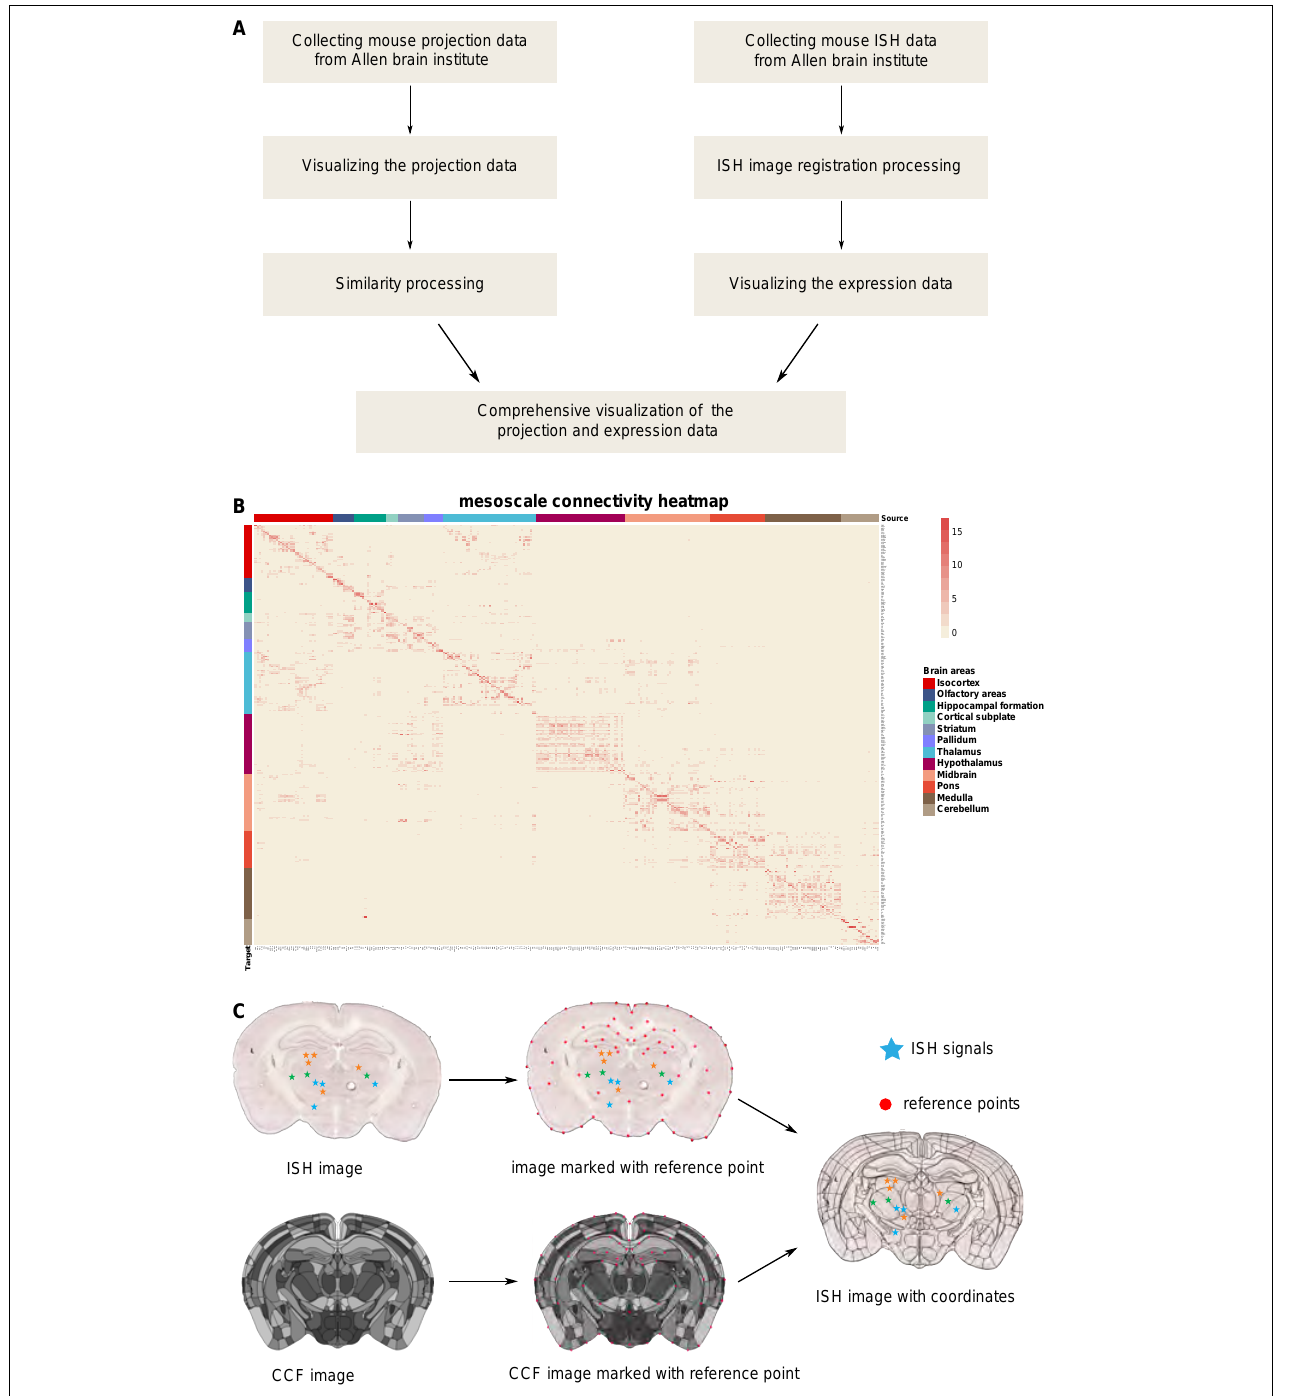
FIGURE 1 | The database processing flow for connectome and chemo-connectome. (A) Data processing flowchart for creating connectome and chemo-connectome databases. (B) Heatmap of the whole-brain connectivity at mesoscale level. The full names of abbreviations for all the source and target areas are listed in Supplementary Table 6 . (C) Diagram of the ISH data processing. ISH, in situ hybridization; CCF, common coordinate framework.